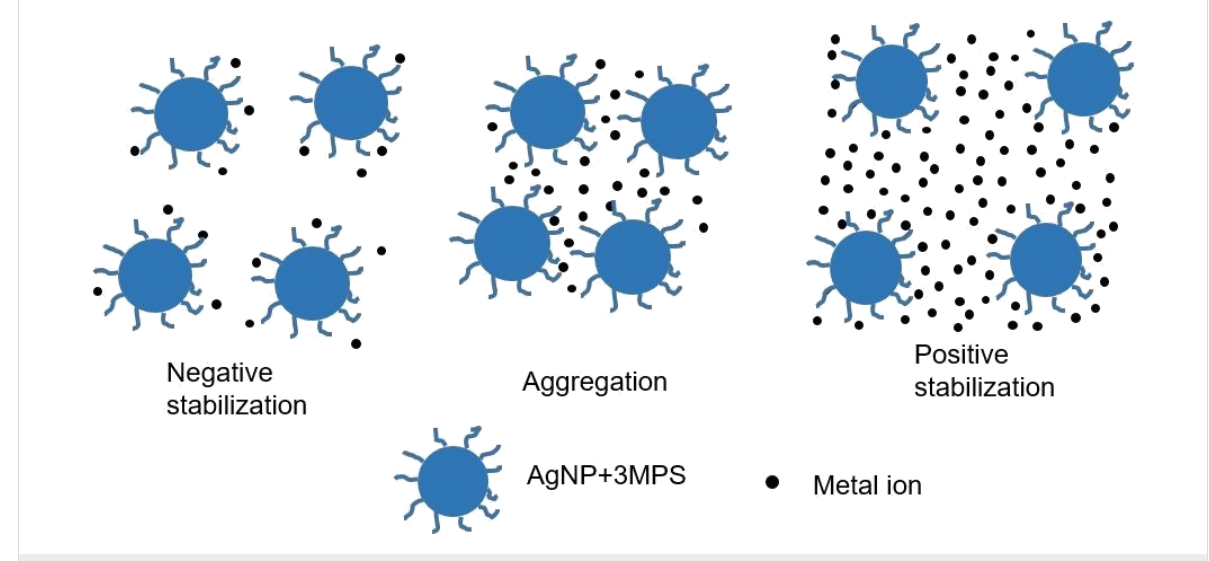
Figure 9: Model of the interaction of AgNP-3MPS and metal ions .